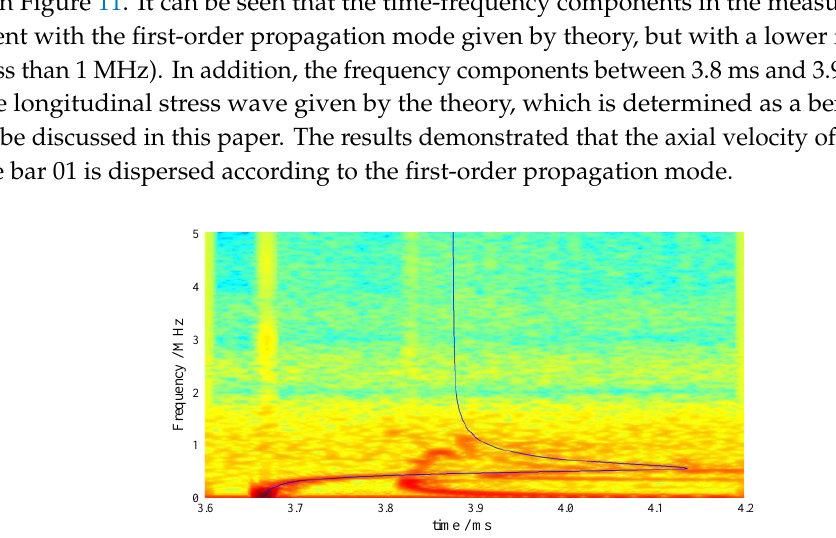
Figure 12. Time-frequency joint spectrum of the free surface velocity of bar 04. A similar analysis method as that used on bar 01 was applied on data from bar 04. Values of size and elastic wave velocity of bar 04 were used in the corresponding formulas, meanwhile, the theoretical propagation mode curves of corresponding orders were drawn in the time-frequency diagram. As shown in Figure 13, the first three propagation modes are excited and in good agreement with the theoretical ones. Table 4 shows the frequency range of the first three propagation modes . time / ms 3.5